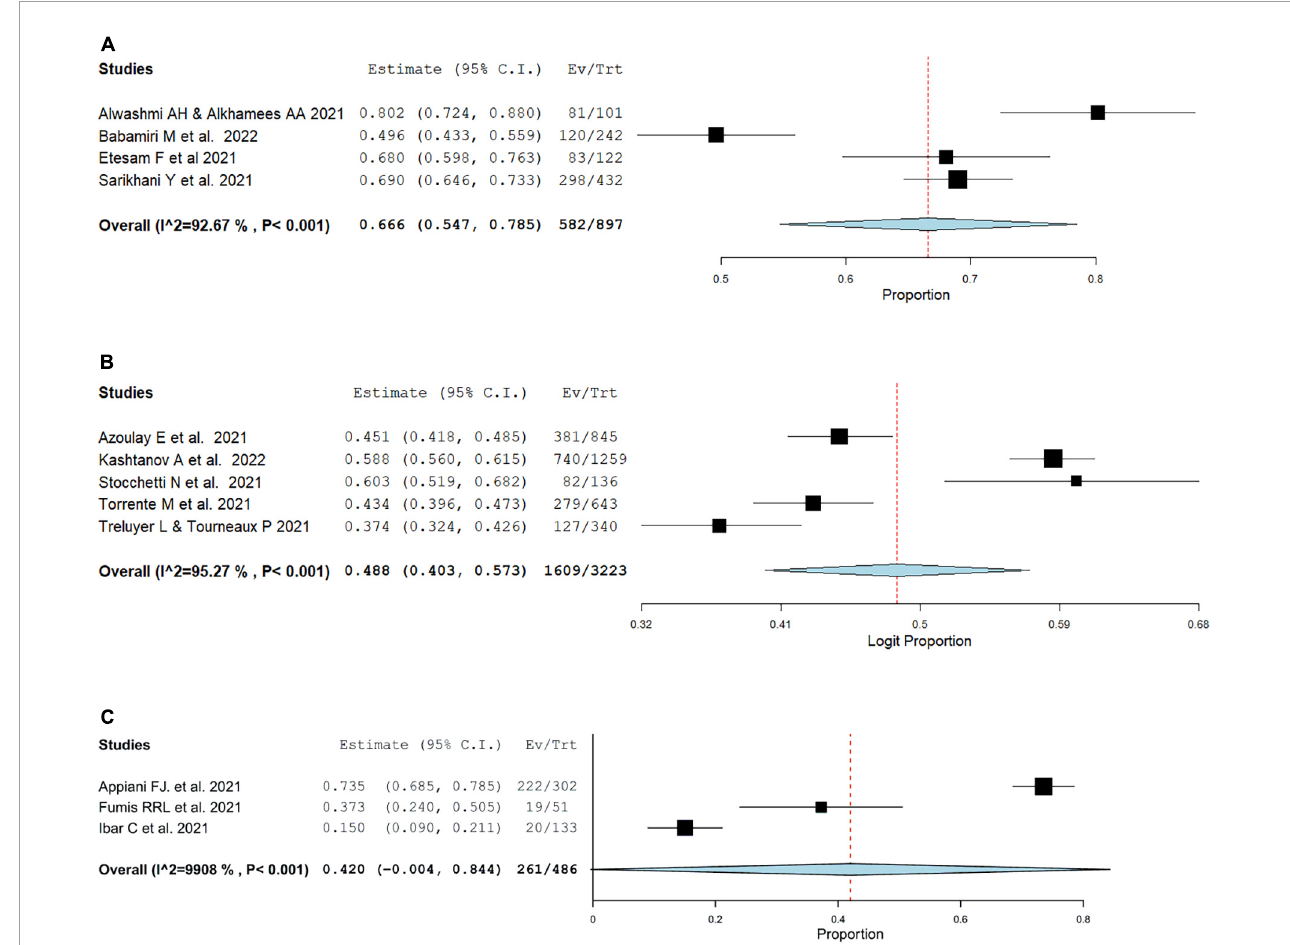
FIGURE4 Pooled estimate of burnout prevalence according to Maslach burnout inventory in (A) MENA, (B) Europe, (C) South America. Asian studies forest plots could not be pooled due to burnout scale